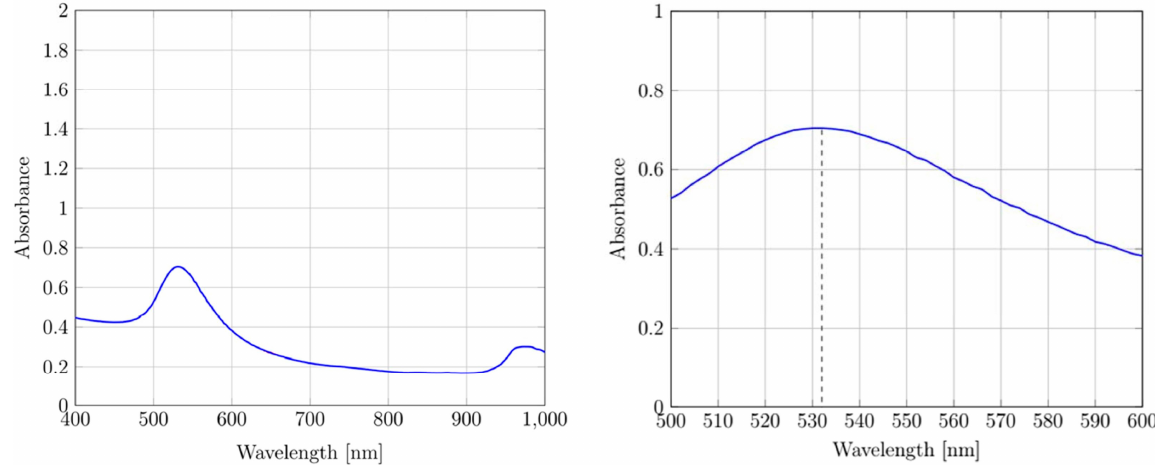
Figure 4. UV–vis measurement spectrum with a signature peak for